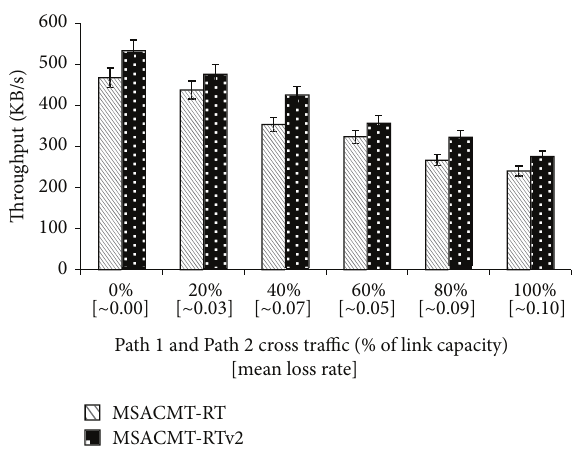
Figure 8: Asymmetric loss conditions: Path 3 = 50% cross traffic.